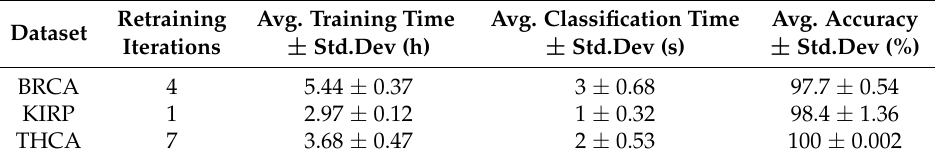
Table 3. Performance of the HD classification